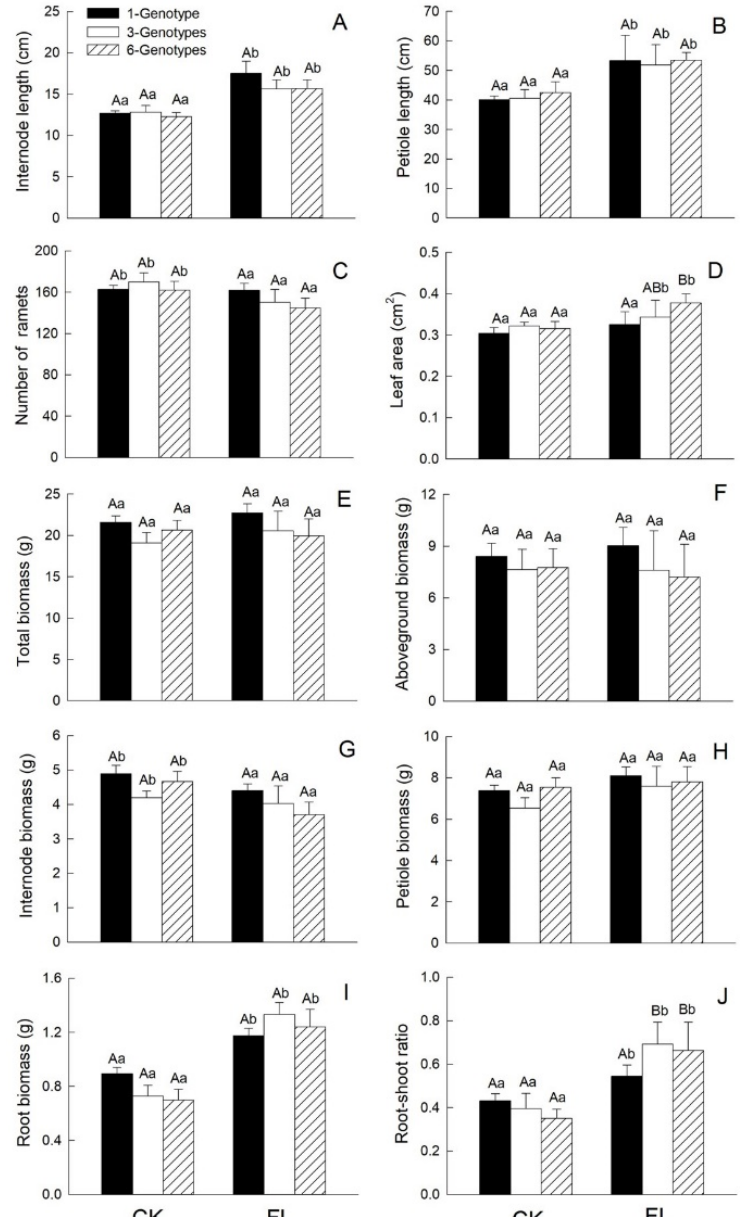
Figure 2. Effects of genotypic diversity and flooding on growth traits ( A ) Internode length, ( B ) Petiole length, ( C ) Number of ramets, ( D ) Leaf area, ( E ) Total biomass, ( F ) Leaf biomass, ( G ) Internode biomass, ( H ) Petiole biomass, ( I ) Root biomass and ( J ) Root to shoot ratio of H. vulgaris (mean ± SE). The control and flooding treatment were named as CK and FL respectively. Different capital letters indicate significant differences among genotypic diversity treatments, and lower-case letters indicate significant differences among flooding treatments ( p < 0.05).